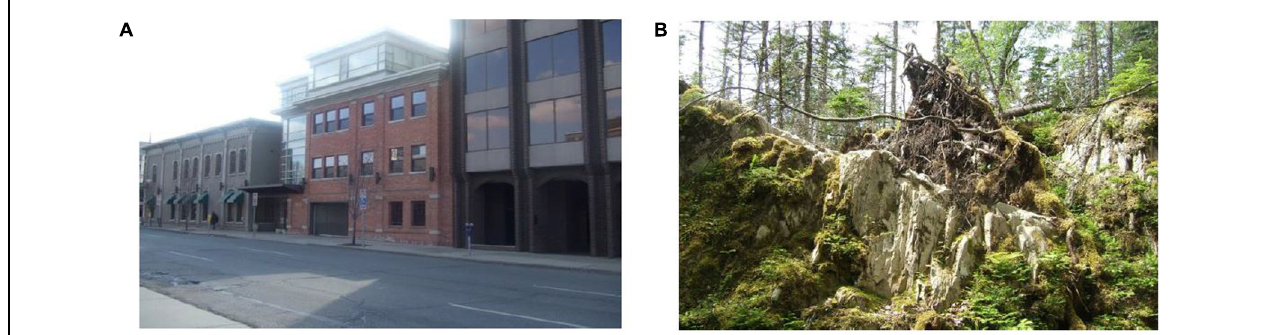
FIGURE 3 | Comparison of two images in their Entropy. (A) Example on an image with low entropy, Entropy = 6.92 (B) Example on an image with high entropy, Entropy = 7.76.